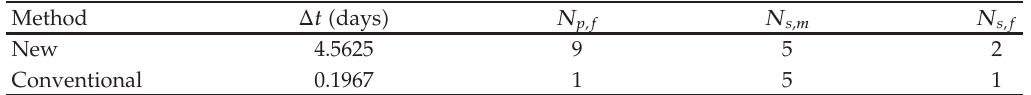
Table 5: Comparison of Example